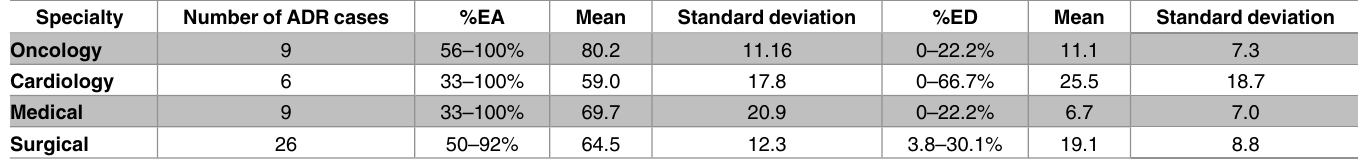
Table 2. Breakdown of percentage agreementand extremedisagreement between